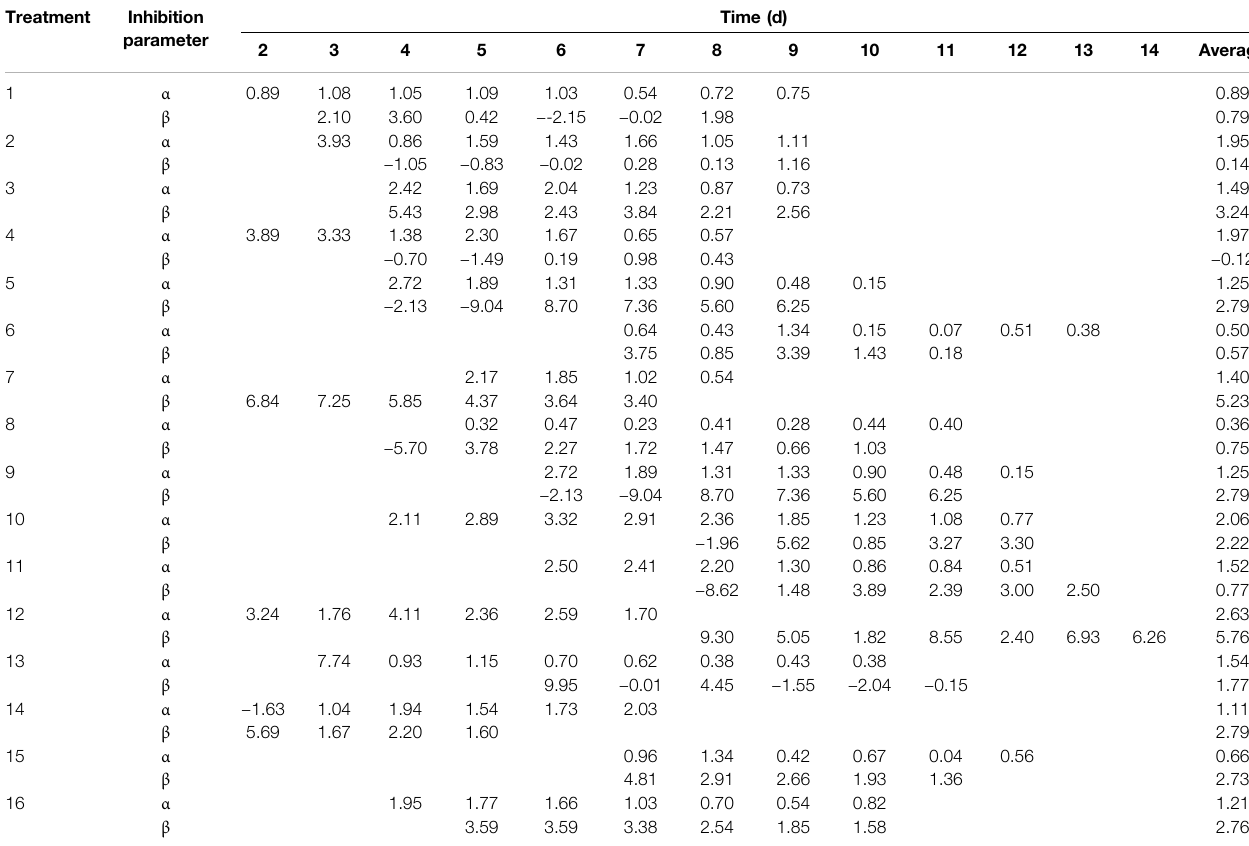
TABLE 4 | Inhibition parameters of Chlorella vulgaris and Anabaena sp. strain PCC after in fl ection point at different conditions. Treatment Inhibition